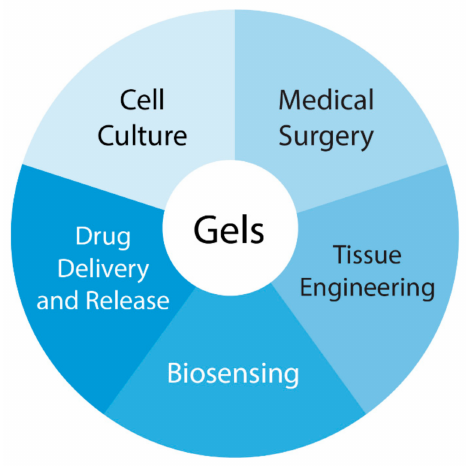
Figure 3. Applications of hydrogels in